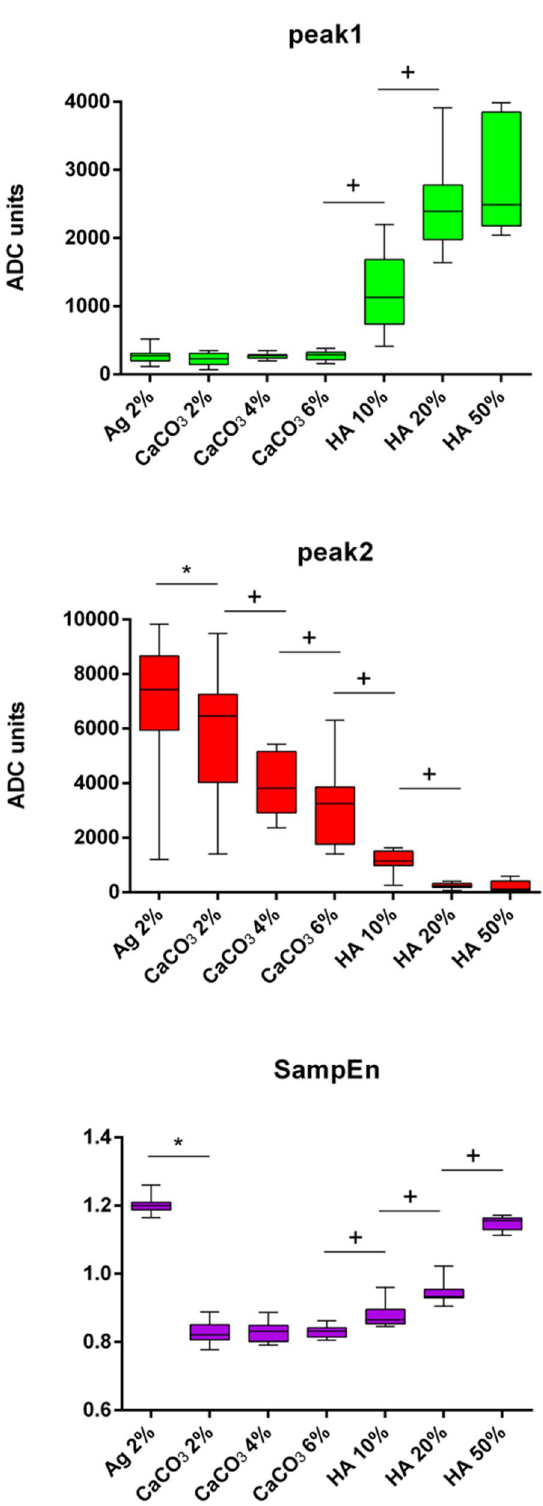
Figure 6. Boxplot statistics for the reflection at the first interface (peak1), the reflection at the second interface (peak2) and SampEn for samples related to different concentrations of CaCO 3 and HA particles. The symbol * indicates p < 0.05 for the comparison of the groups to the control group, the symbol + indicates p < 0.5 for the comparison of the groups to each